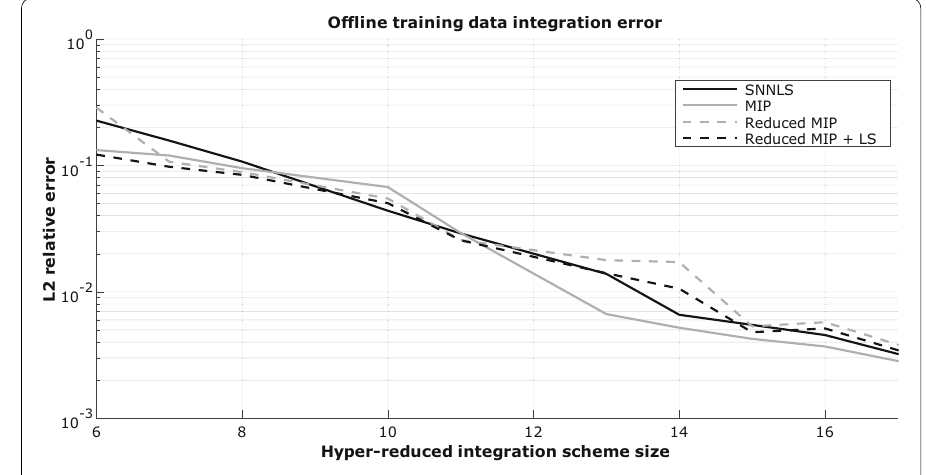
Fig. 11 Offline training data relative L2 error (33) of SNNLS and proposed hyper-reduced methods. Hyper-reduced integration schemes sizes range from 6 to 17